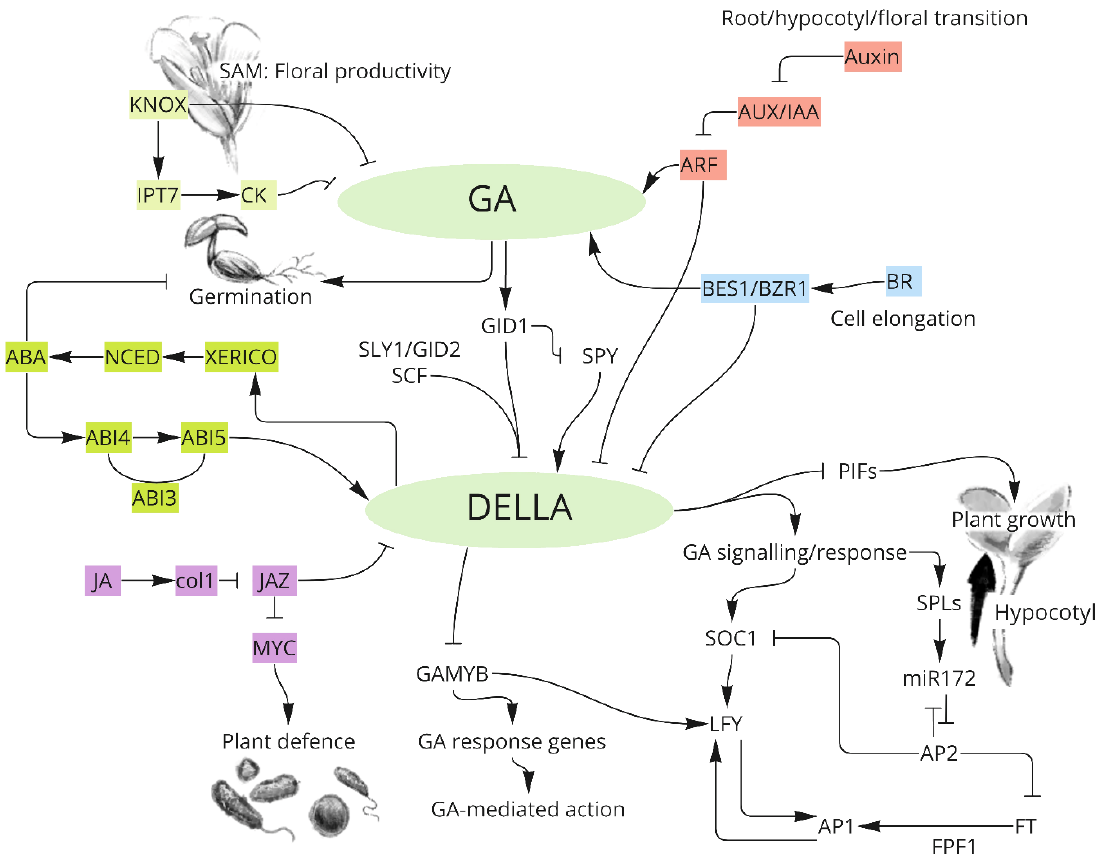
Figure 2. Gibberellin (GA) signal transduction pathways and crosstalk between GA and phytohor- mones in mediating key developmental events in Arabidopsis. KNOX: KNOTTED1-like homeobox; IPT7: ISOPENTENYL TRANSFERASE7; CK: cytokinin; NCED: 9-cis-epoxycarotenoid dioxygenase;